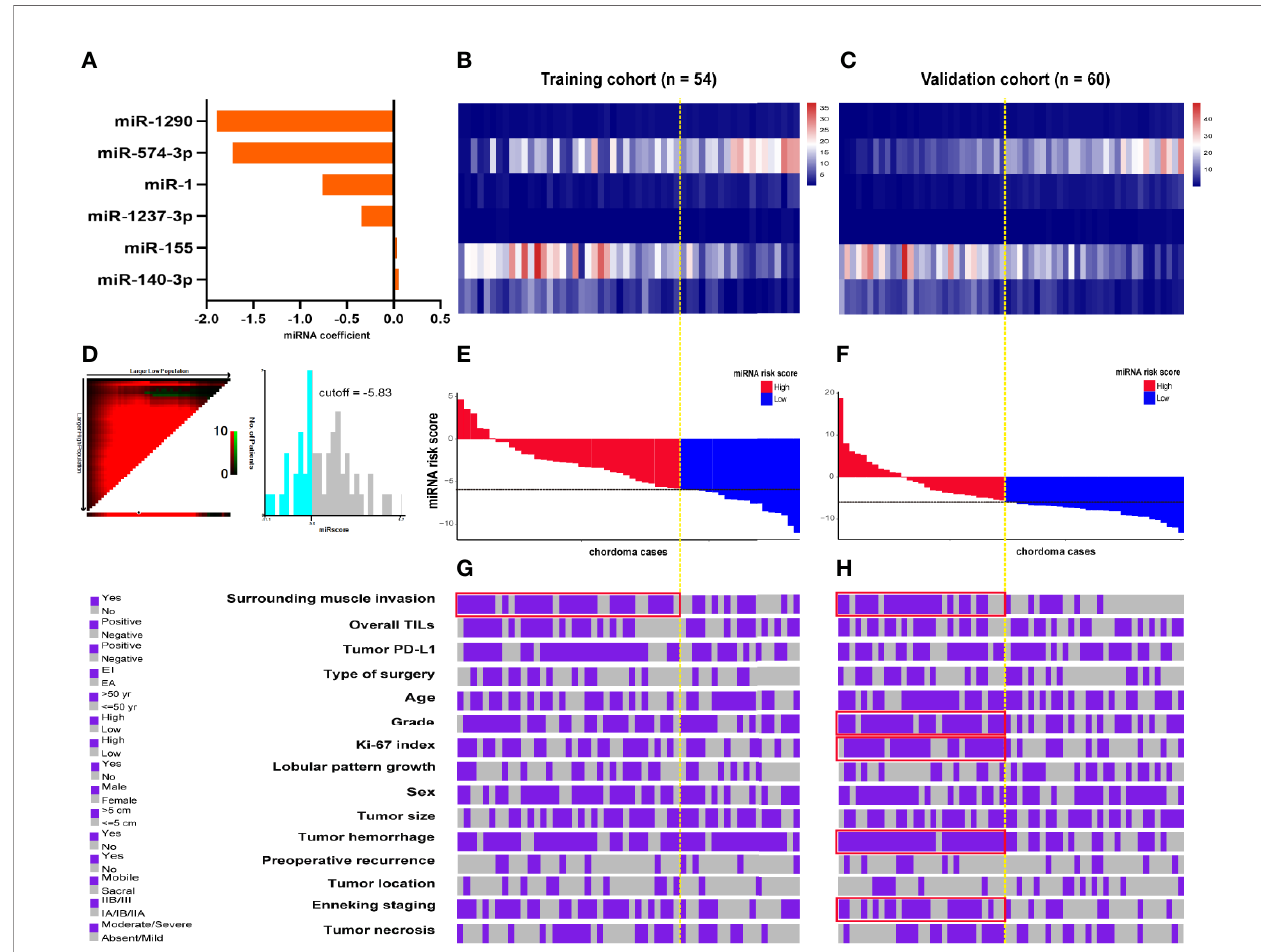
FIGURE 4 | (A) Coef fi cient of each prognostic miRNA obtained by Cox regression analysis. Heatmap shows the expression data of the six miRNAs used for the miRscore construction in the training (B) and validation cohort (C) . Columns represent patients who were sorted descendingly according to their miRscore levels. (D) Determination of the cutoff point (-5.83) for miRscore in prognosis analysis with overall survival as the outcome parameter. Distribution of the miRscore in the training (E) and validation patients (F) . The x-axis represents patients. The intersection point of black and yellow dotted line represents the miRscore cutoff classifying patients into high and low subgroups. (G, H) Covariate tracks show the clinical attributes of each patient in the training and validation cohort, respectively. Red boxes indicate that the miRscore group is enriched for the indicated attribute ( P < 0.05, Chi-square test). miRscore, microRNA risk